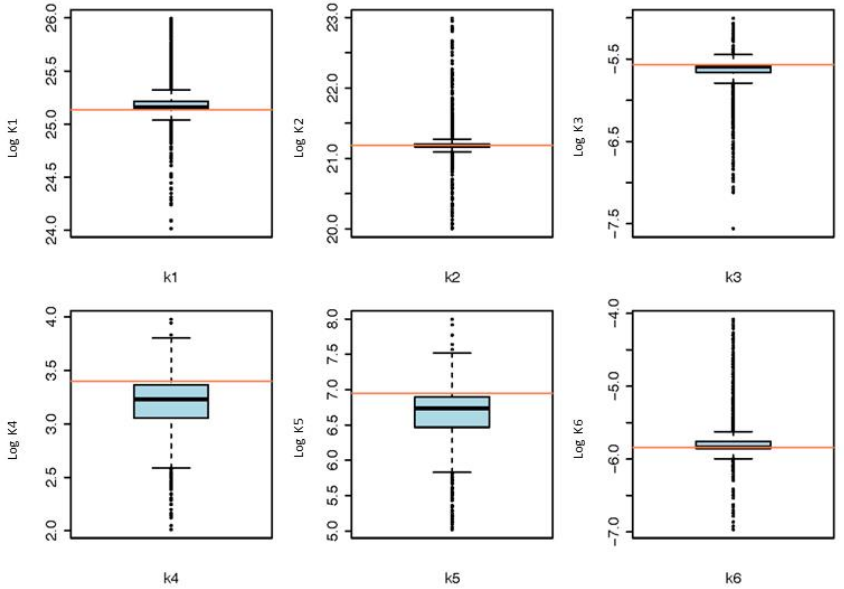
Figure 4. Boxplots for the optimized parameters. The horizontal red lines indicate the optimum value for each parameter. Parameter names are defined in Table 1.